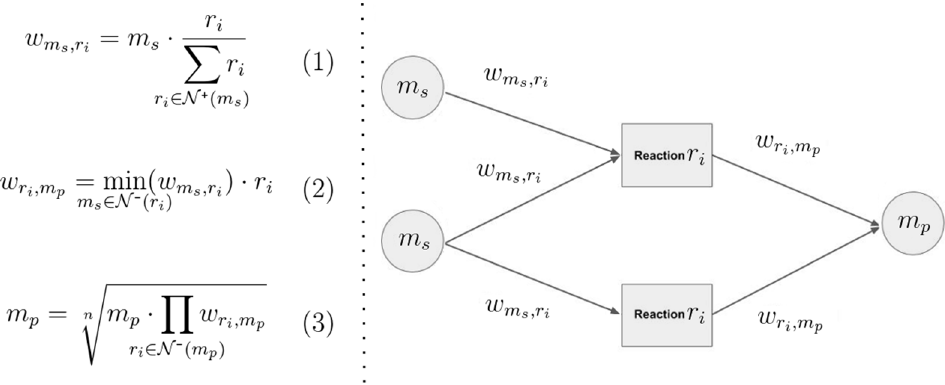
Figure 4. Recursive rules of the propagation algorithm.